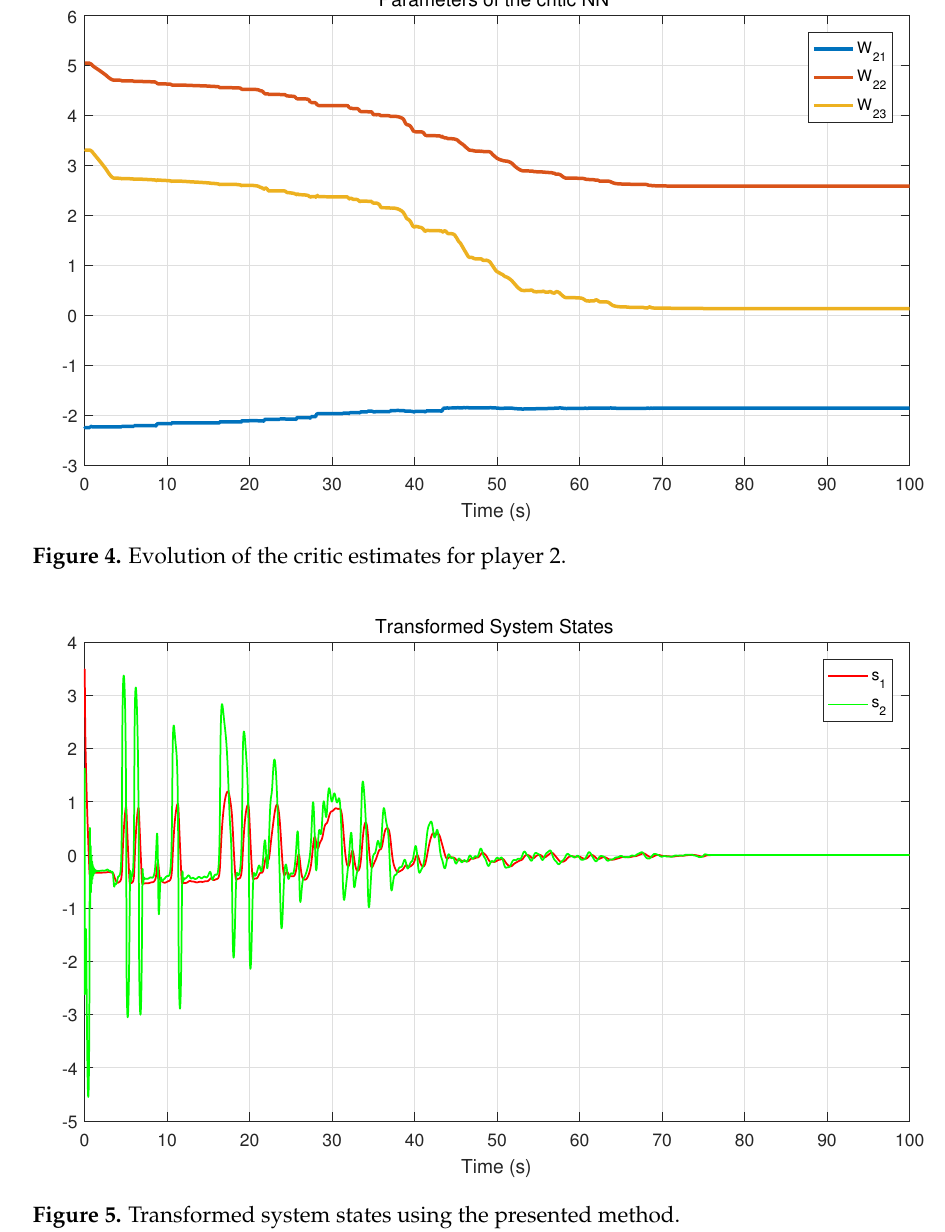
Figure 5. Transformed system states using the presented